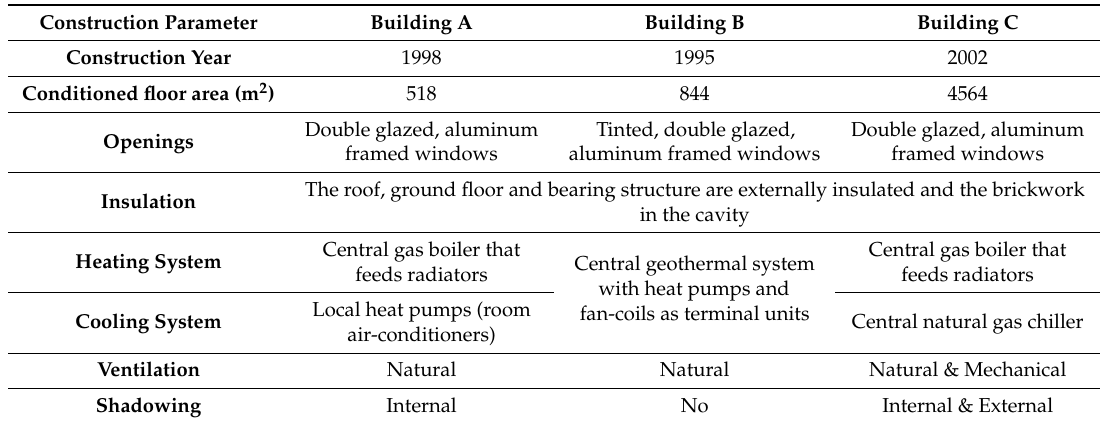
Table 1. Description of buildings under